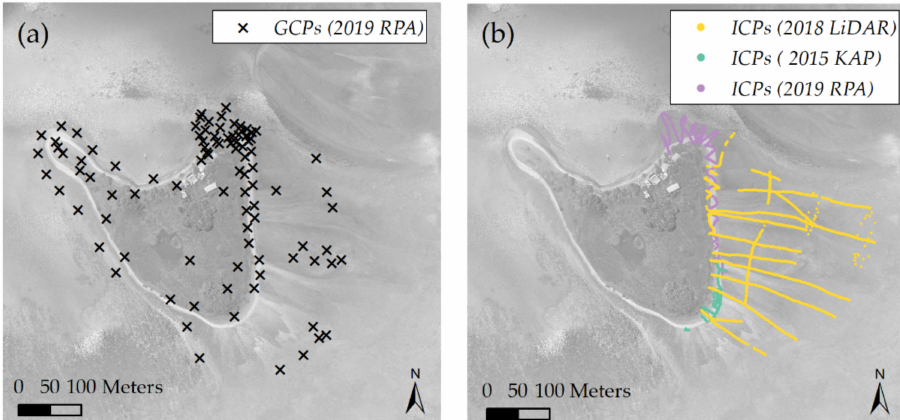
Figure 3. Examples of ( a ) GCPs configuration used to georeference the 2019 RPA dataset and ( b ) ICPs used to estimate the vertical accuracy of the 2015 KAP, 2018 LiDAR, and the 2019 RPA datasets. Background image: 2018 LiDAR mosaic.